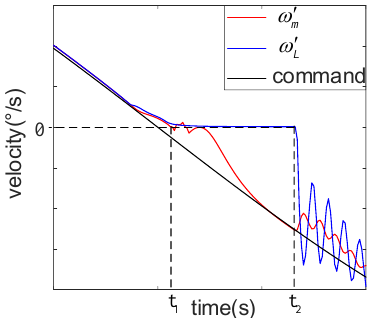
Figure 3. Principle of the online backlash test method.